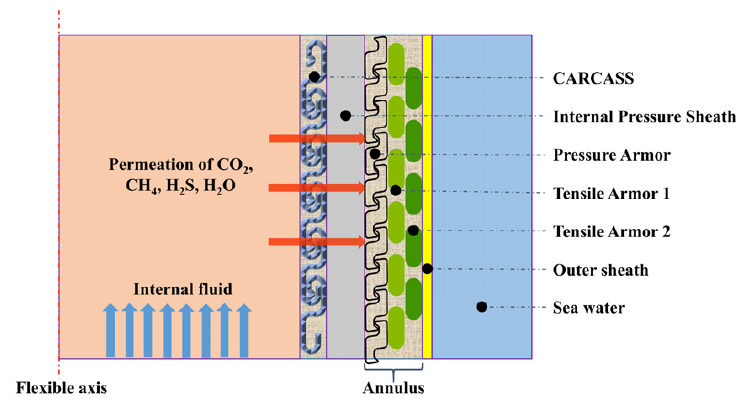
Figure 1. Permeation in the flexible riser.